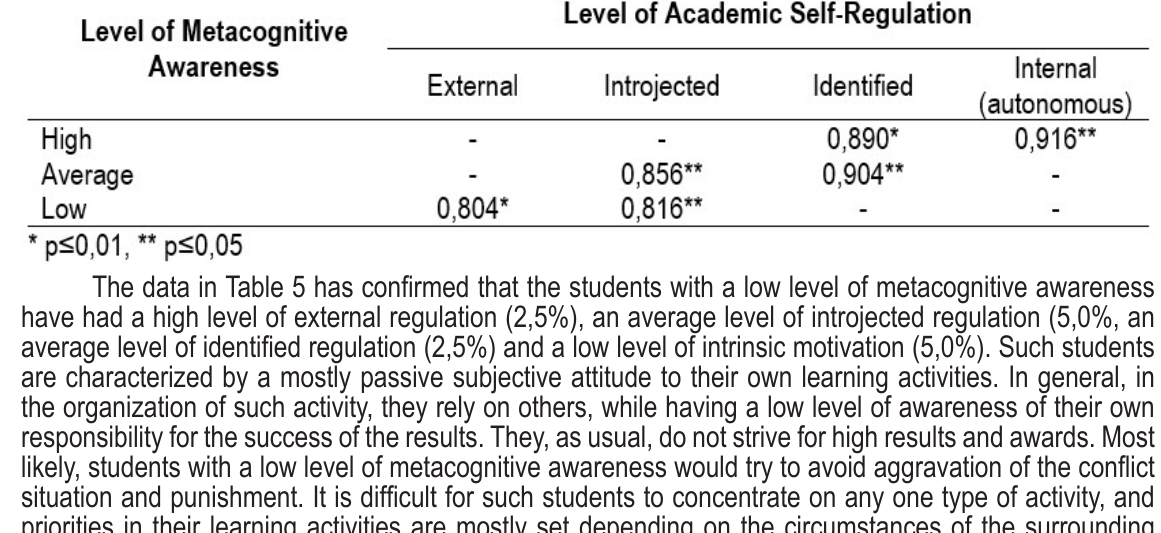
Indicators of correlation between metacognitive awareness and academic self-regulation of